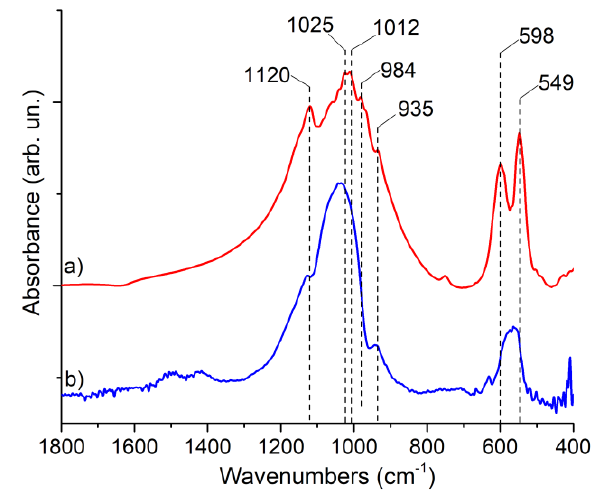
Figure 3. FTIR spectra of ( a ) Mn,Sr-TCP target and ( b ) Mn,Sr-TCP coating deposited on